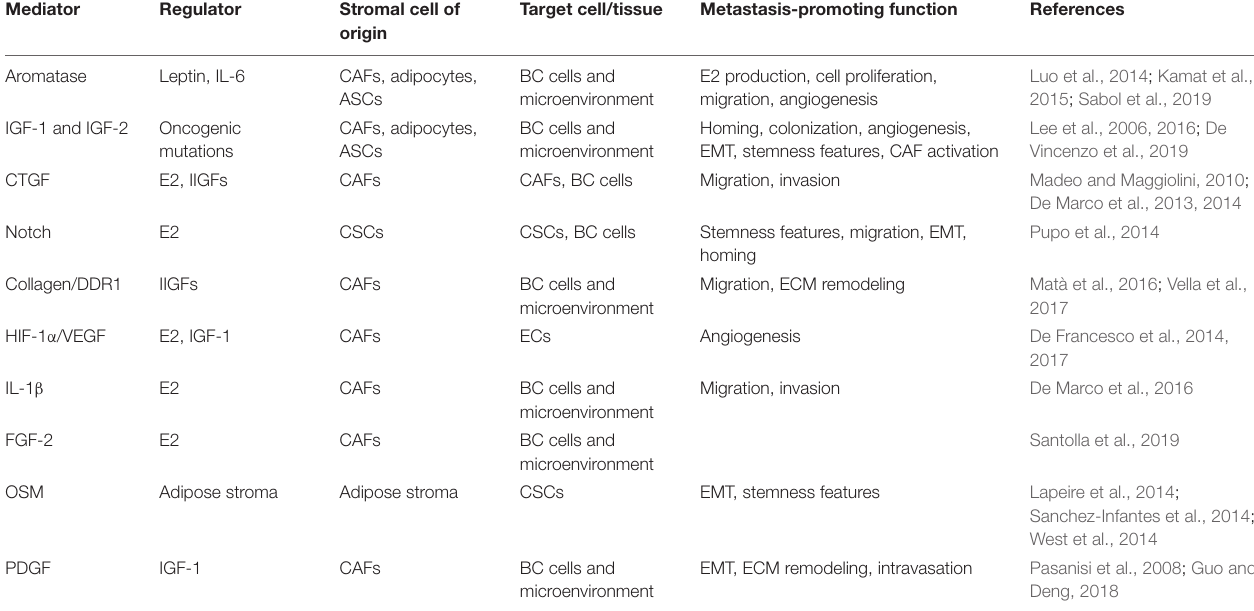
TABLE 2 | Schematic representation of the main stromal mediators involved in metastatic progression by estrogen and IIGF